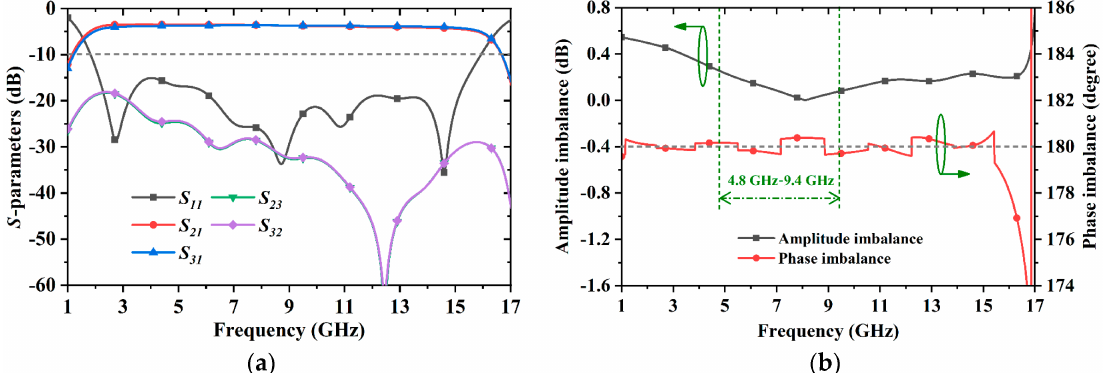
Figure 13. ( a ) Simulated S-parameters of the ultra-wideband feeding balun. ( b ) Simulated amplitude imbalance and phase imbalance at two out ports of the ultra-wideband balun.